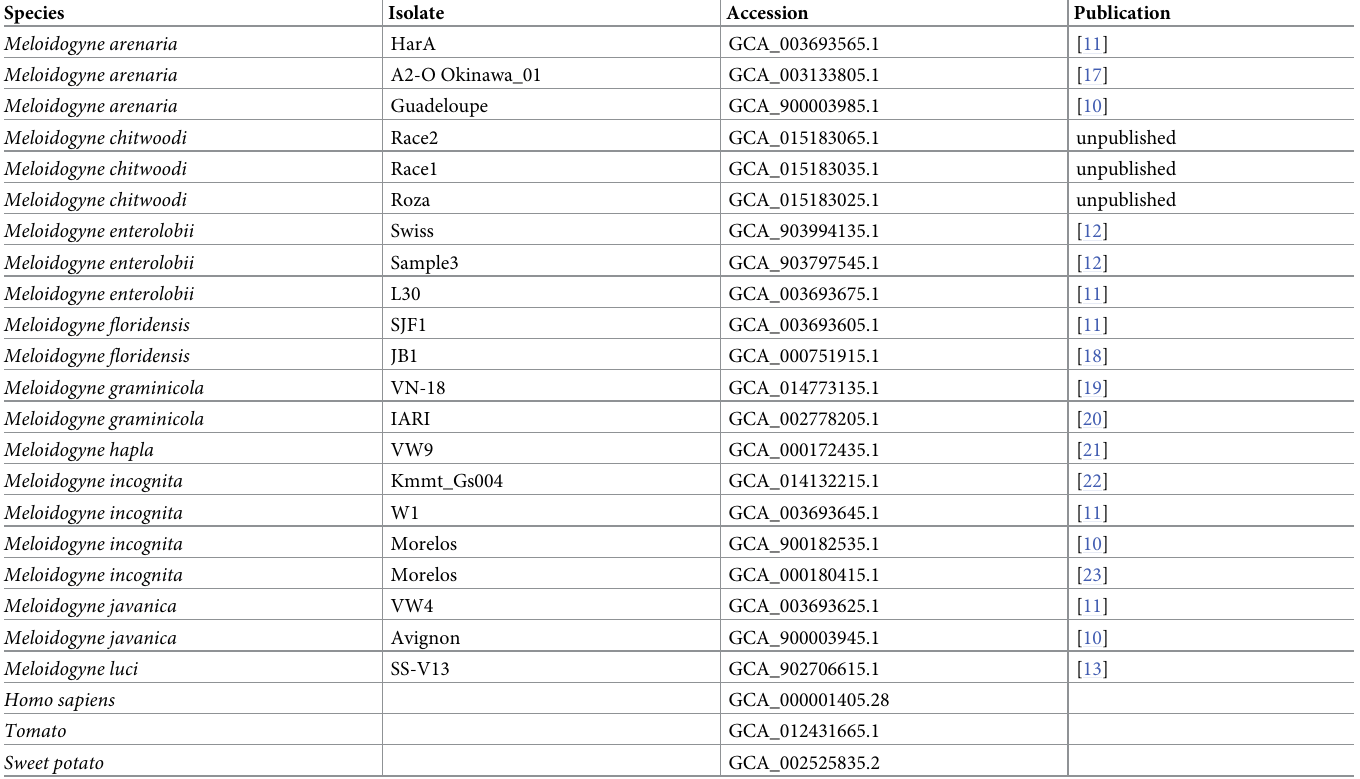
Table 1. Species within the Kraken 2 database. Eleven species of RKN with 21 total genomes are shown in addition to three non-nematode species included to identify